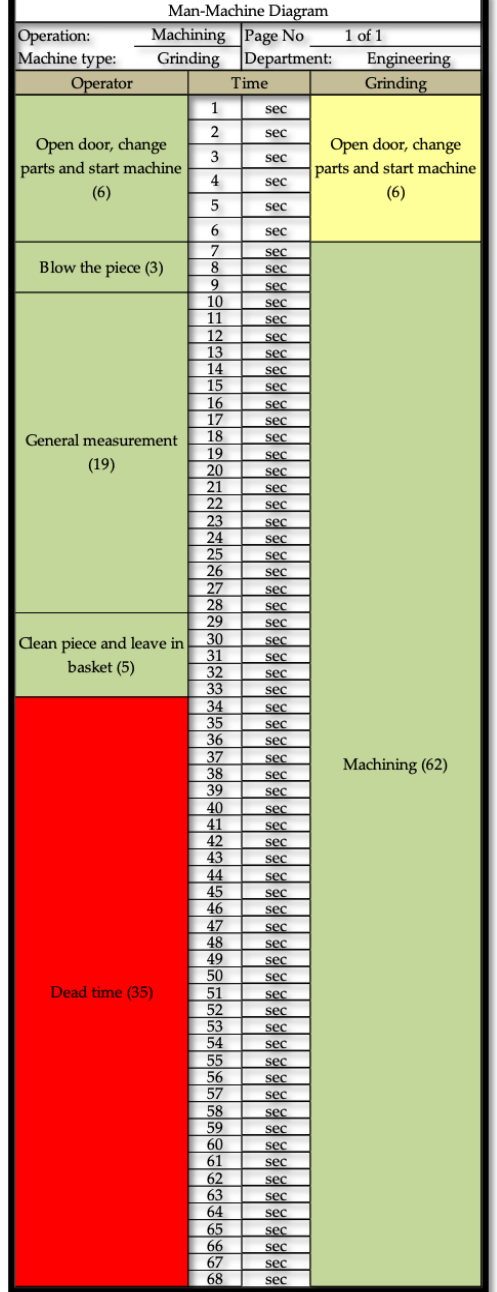
Table 2. Man-machine diagram of grinding process